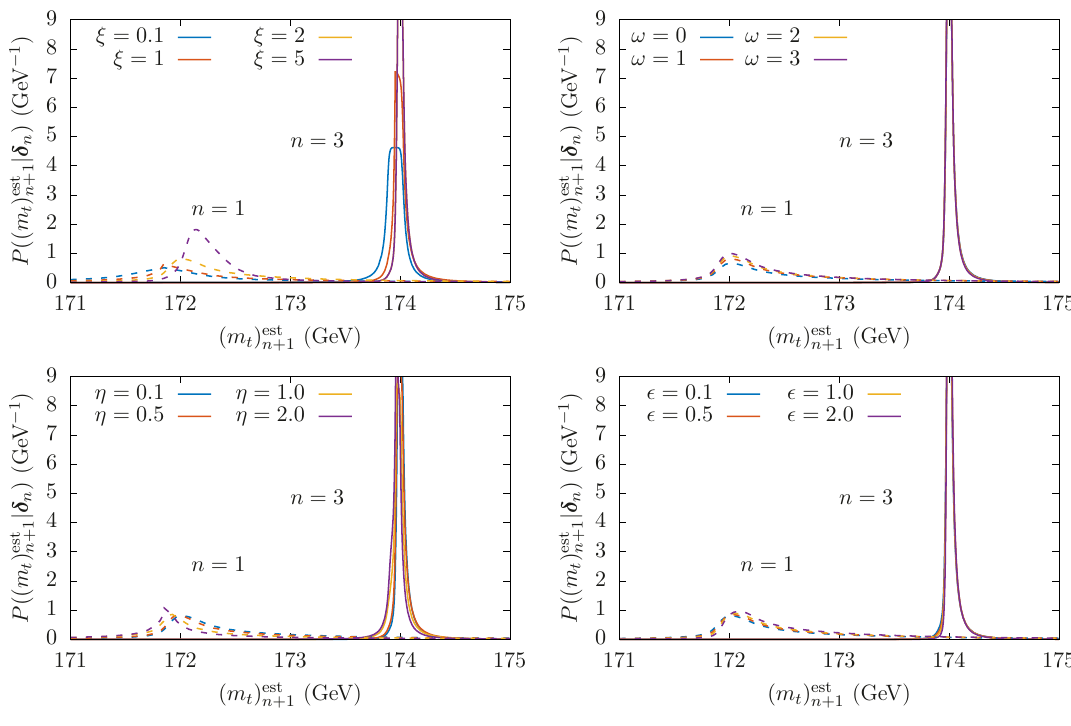
− ( m t ) n ) / ( m t ) 0 | δ n ) n +1